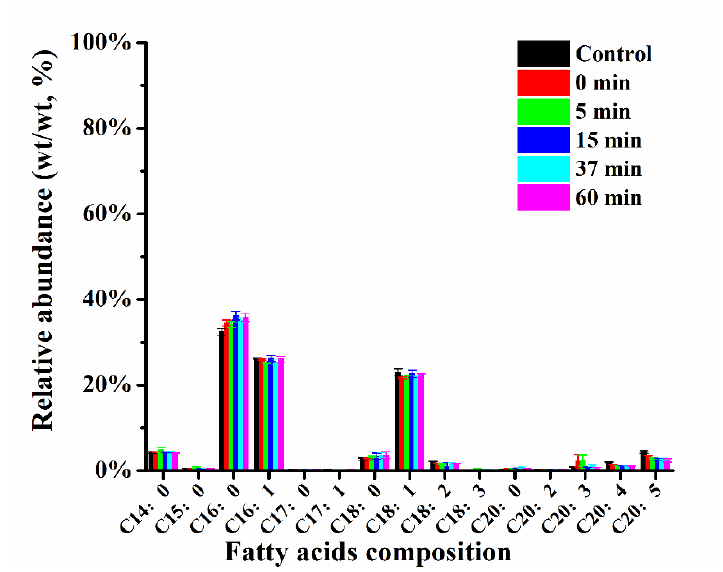
Figure 3. Effect of electrolysis time on the composition of extracted fatty acids from N. oceanica IMET1.